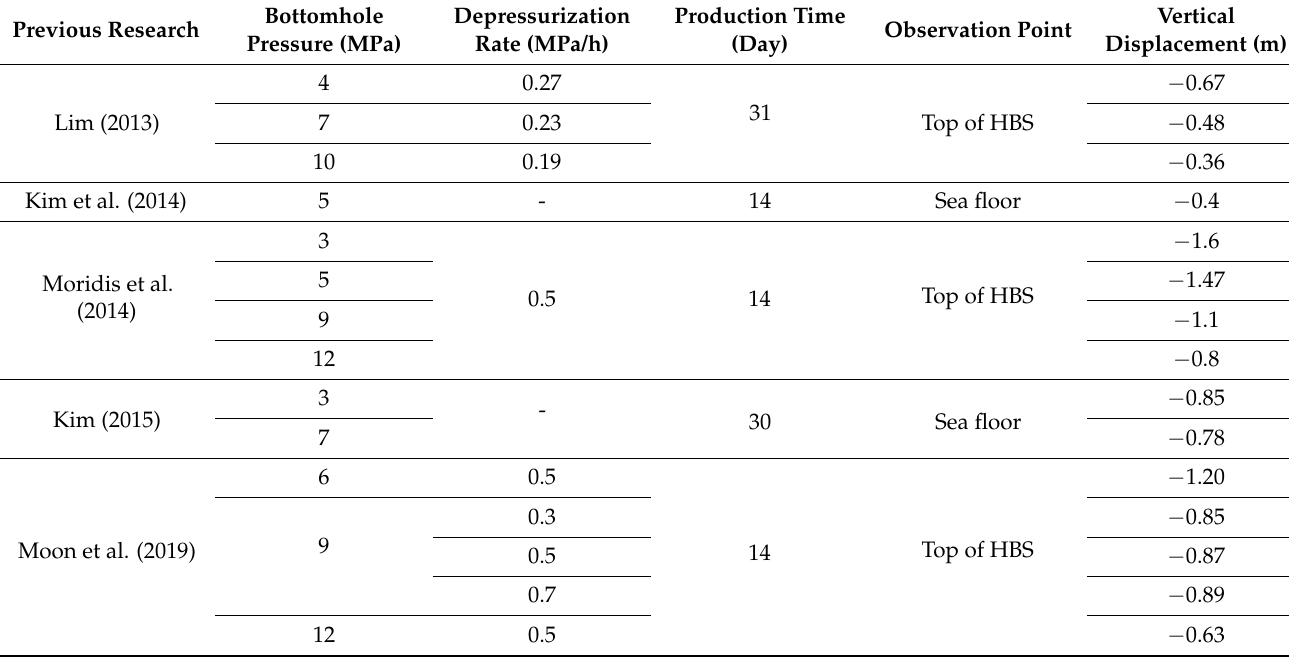
Table 2. Vertical displacements in previous researches.